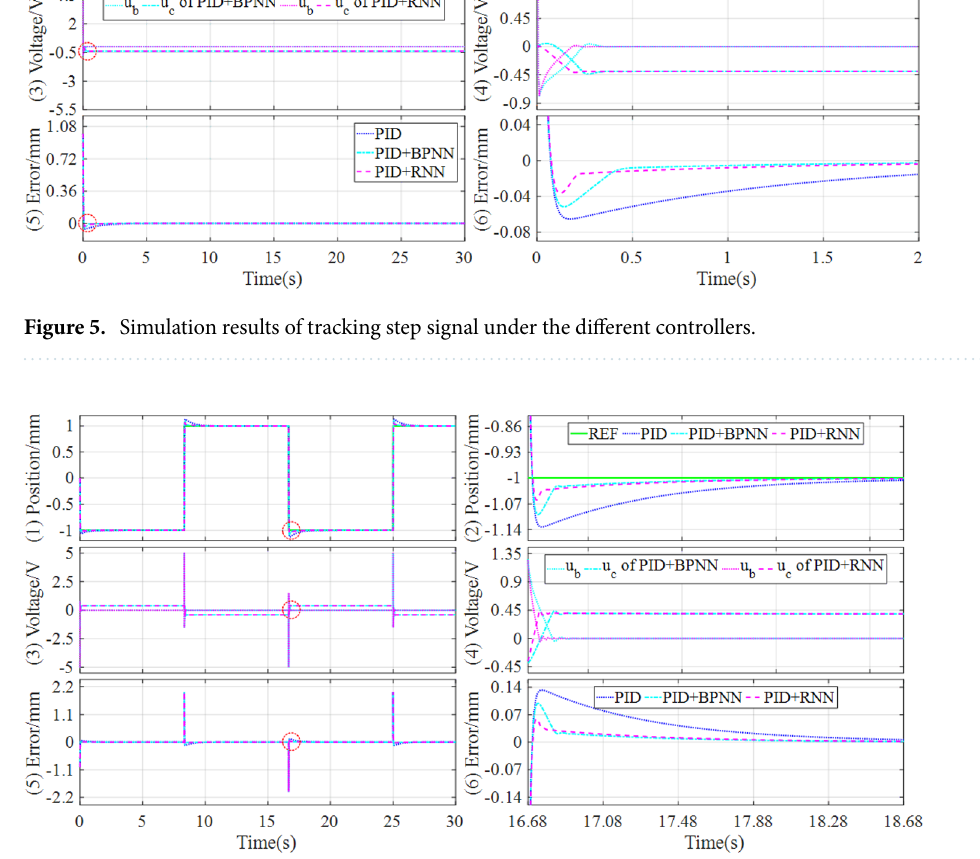
Figure 6. Simulation results of tracking square signal under the different controllers.